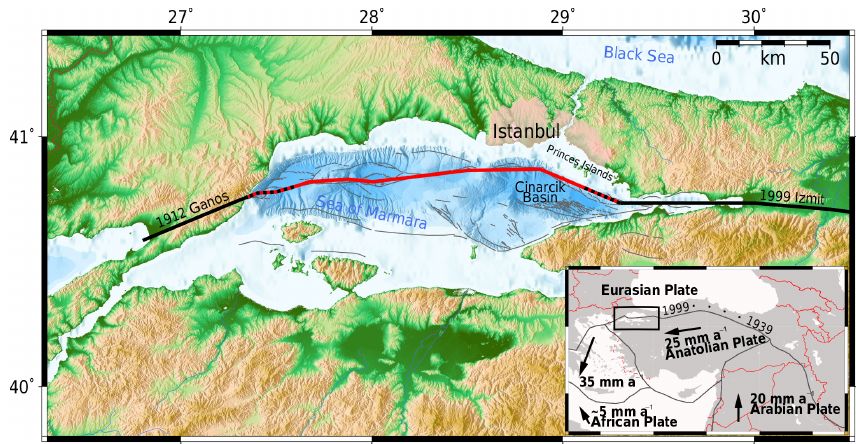
Figure 1. The Marmara region in northwestern Turkey with the main strand of the North Anatolian Fault Zone (NAFZ). The offshore Marmara section (red) is bounded by the two last major ruptures of the region, the 1912 Ganos event to the west and the 1999 Izmit event to the east (both indicated in black). The Marmara section is the last segment of the entire NAFZ that has not been activated since 1766. It hosts the potential of generating an earthquake magnitude M of up to 7.4 in the near future and within a distance of only 20km to the Istanbul metropolitan area. The location map on the lower right shows the main tectonic plates and their average GPS-derived horizontal velocity with respect to fixed